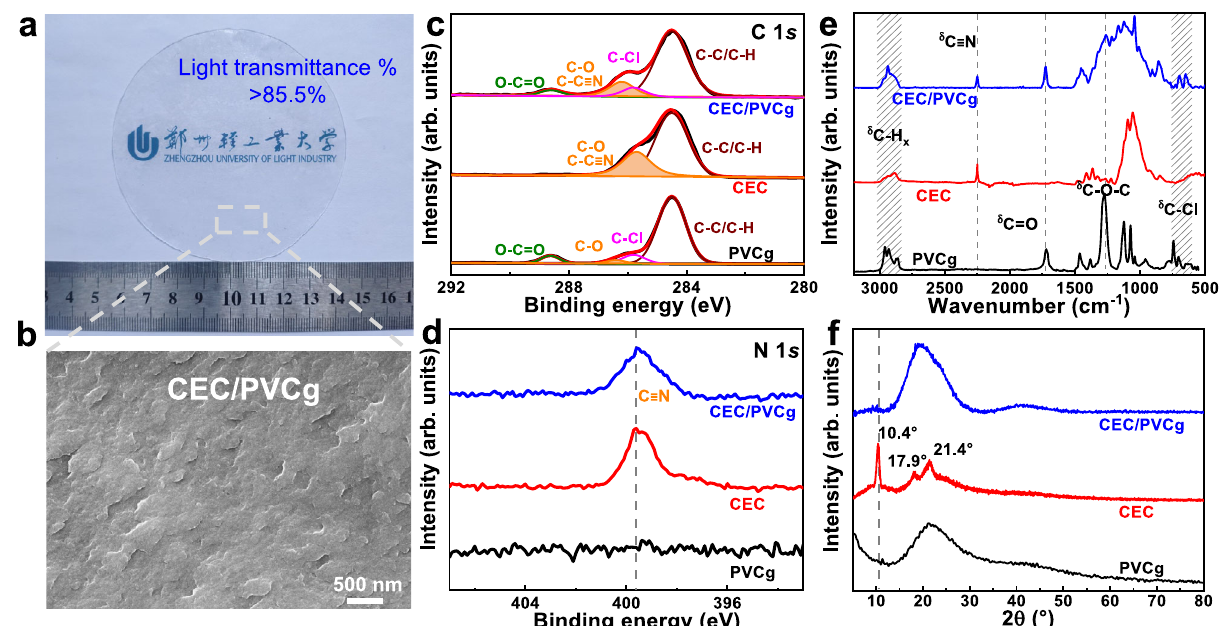
Fig. 2 | PhysicochemicalcharacterizationofCEC/PVCg. An opticalimage ( a )and cross-sectional SEM image ( b ) of the transparent CEC/PVCg elastomer. High- resolution XPS spectra of C 1 s ( c ) and N 1 s ( d ) regions, FTIR spectra ( e ), and XRD diffraction patterns ( f ) of PVCg, CEC, and CEC/PVCg elastomer. The dashed lines